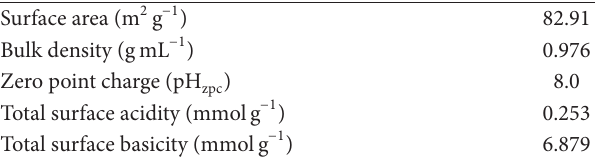
T 1: Characteristics of ANP.